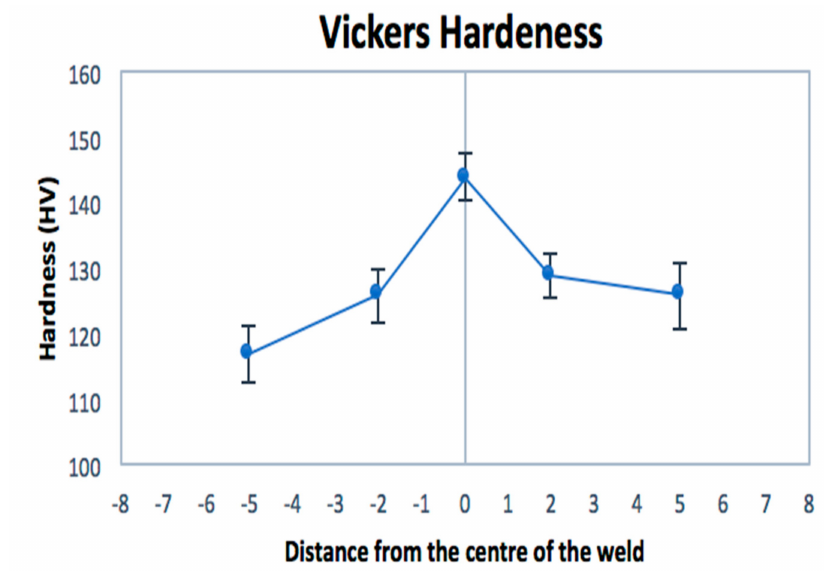
Figure 10. Graph of hardness versus position from the weld centre for Al 7075 alloy EB welded plates. Work done by various researchers on Laser hardening, [19] has shown that the most relevant parameter in the hardened layer depth is the scanning speed, followed by the hardened track width.